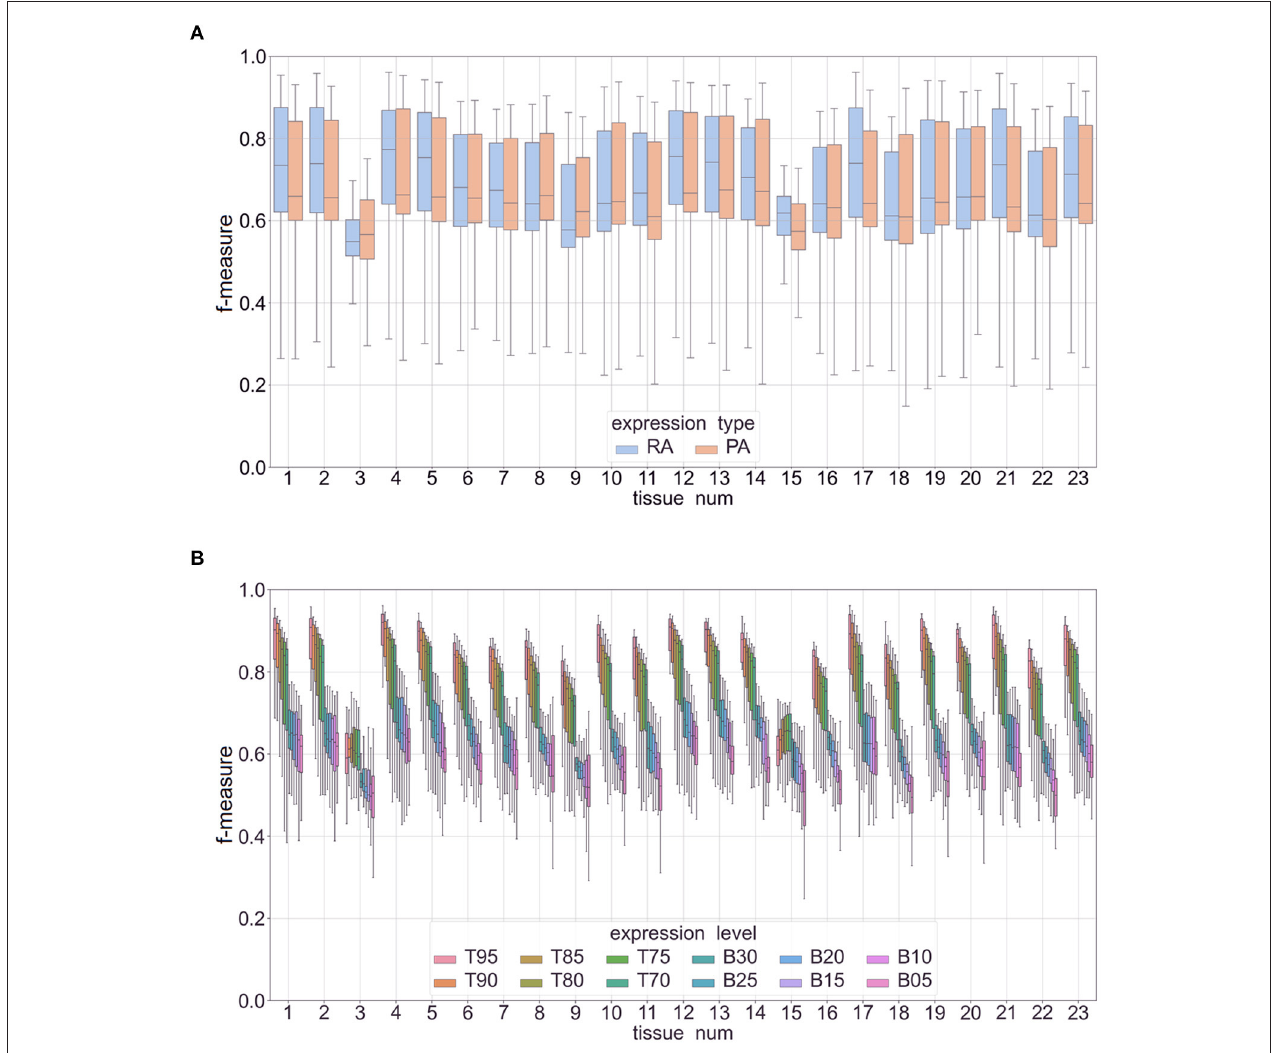
FIGURE 5 | Box plots of F-measures for Phase II classifiers based on two expression types (RA, mRNA abundance; PA, protein abundance). The x-axis is labeled by tissue type (see Table 1 for a full list of tissue names). Panel (A) is a plot of interquartile range and mean of F-measures across the top 5–30% of expression cutoffs, bottom 5–30% of expression cutoffs, and k -mer sizes of 3–7. Panel (B) is a similar plot with separate box plots for each expression cutoff (top expression: T95–T70 and low expression: